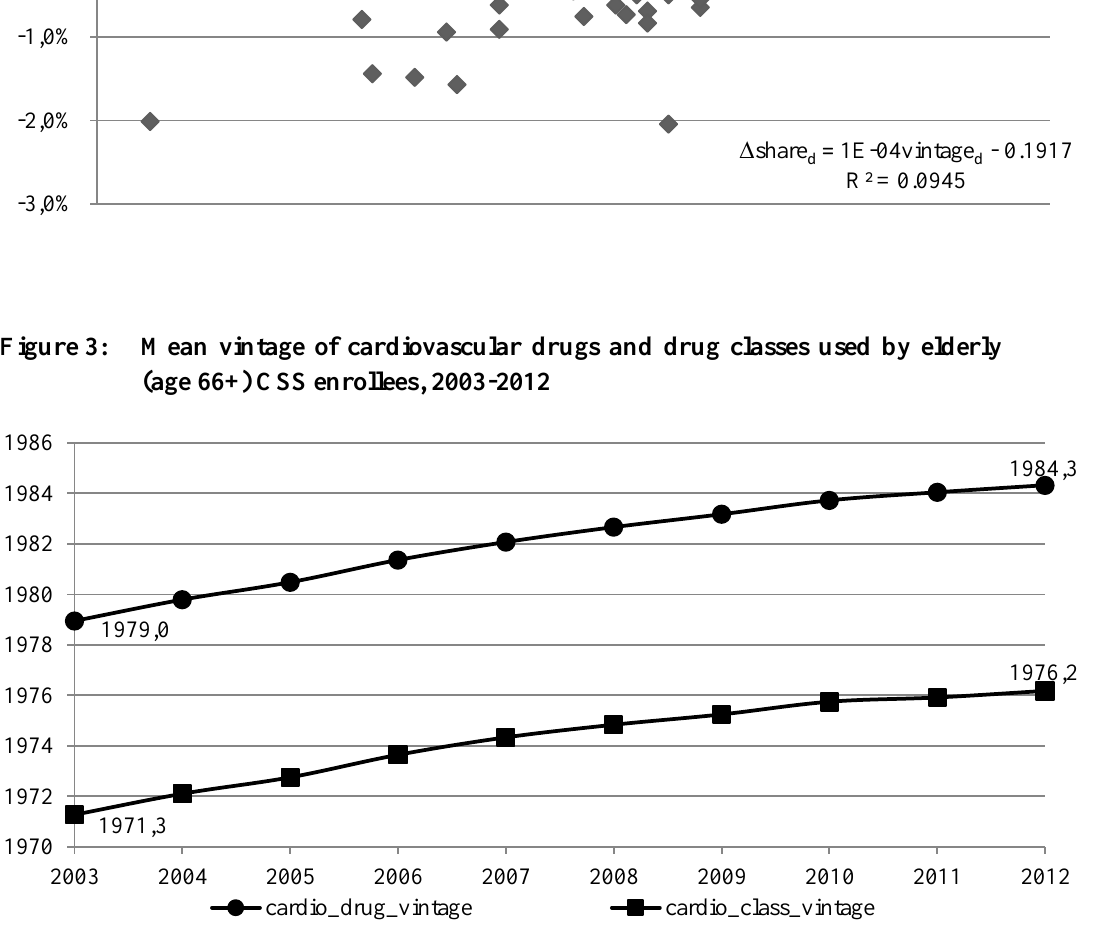
Note: The average annual number of cardiovascular drug prescriptions used by elderly CSS enrollees was 277